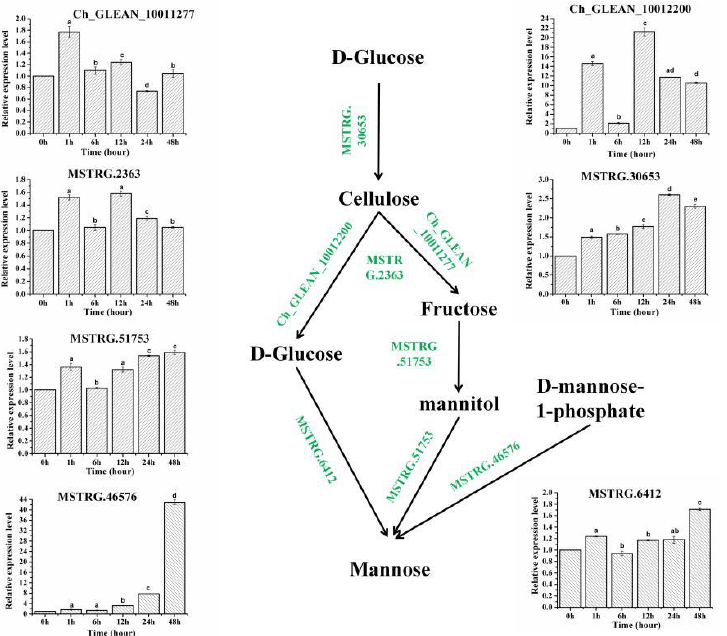
Figure 3. Expression of cellulose and mannose biosynthesis-related genes in H. pluvialis under dif- ferent treatment stages. Note: Different superscript lowercase letters on top of the columns indicate significant differences ( p < 0.05) among the treatments, and any of the same lowercase letters or letter said the difference was not significant ( p > 0.05). Table 1. Effects of SAHL treatments on the measurements of H. pluvialis.